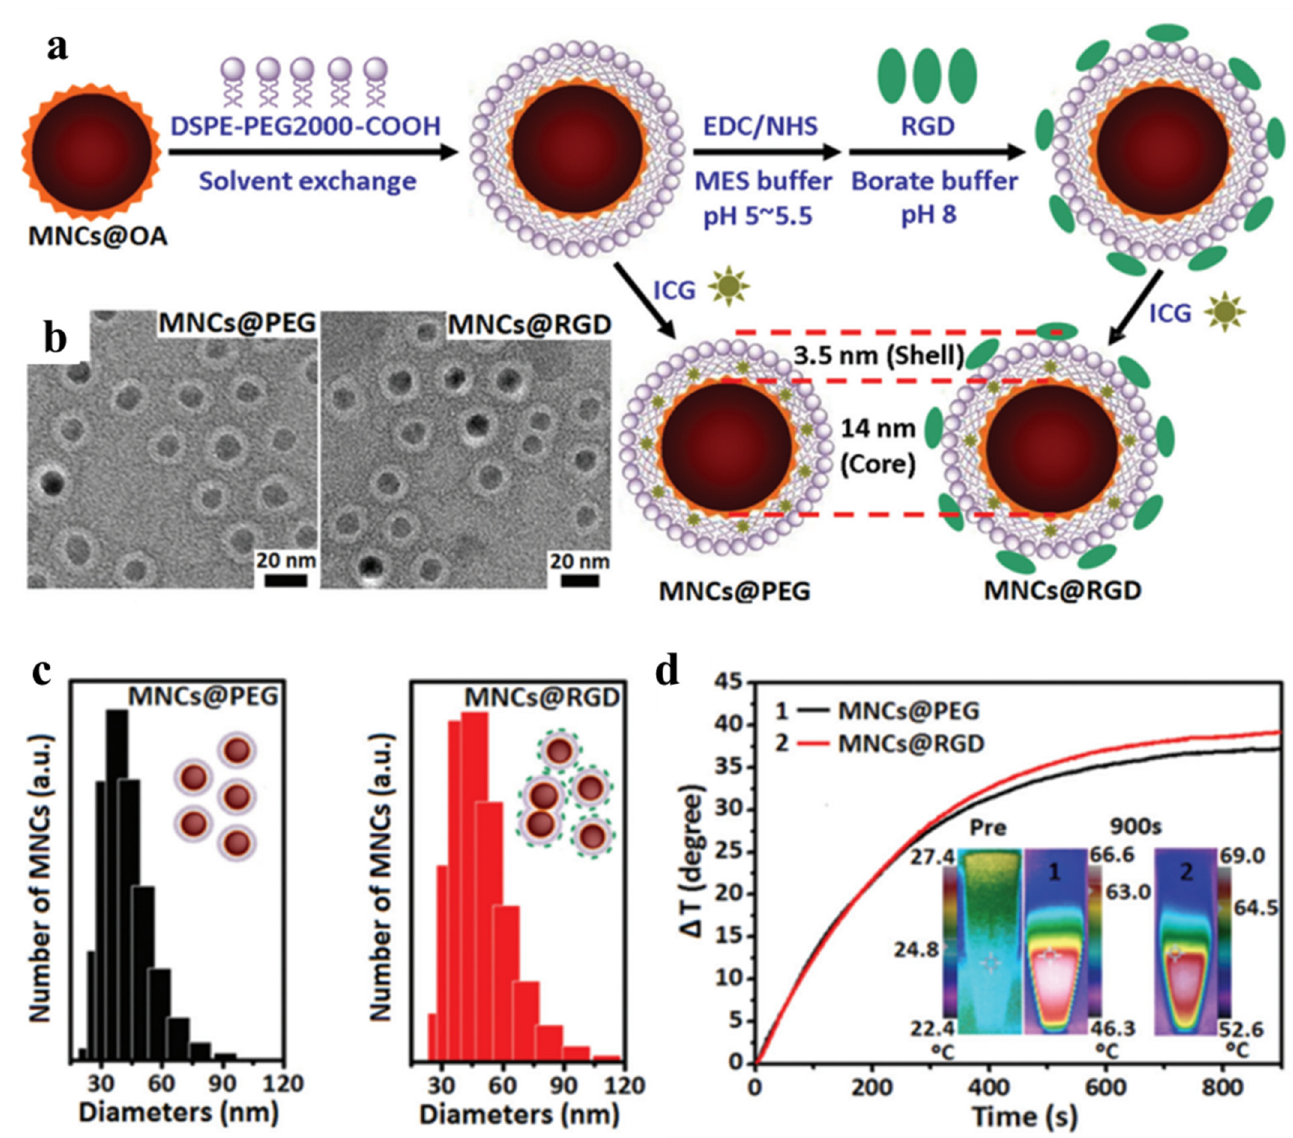
Figure 2. ( a ) The oleic acid (OA)-modified Mn-Zn ferrite nanocrystals (MNCs@OA) were coated with DSPE-PEG2000-COOH through hydrophobic interactions to form MNCs@PEG with entrapped ICG. The peptide ligand arginine–glycine–aspartic acid (RGD) was covalently linked to the nanocomposite to form MNCs@RGD. ( b ) The transmission electron microscope (TEM) images of core–shell structured MNCs after negative staining with 2% phosphotungstic acid reveal a white lipid shell layer covering a core of MNCs. ( c ) The size distribution histogram of MNCs measured from a dynamic light scattering image (DLS). ( d ) The in vitro temperature profile of MNCs (2 mg Fe/mL) after induction with an alternative magnetic field (AMF) at 390 kHz and 2.58 kA m − 1 . The insert shows the near-infrared (NIR) thermal camera images. Reprinted/adapted with permission from Ref. [76]. 2016, The Royal Society of Chemistry.